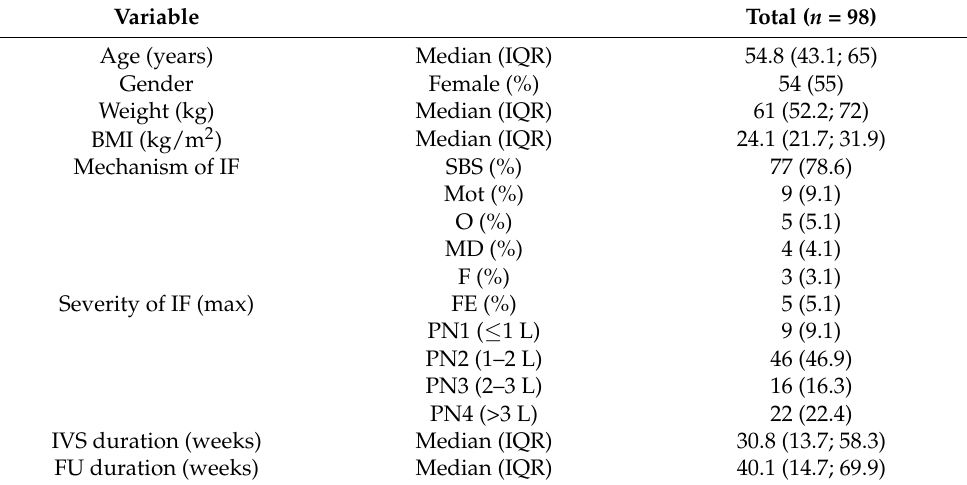
Table 1. Demographics and clinical characteristics of IF patients at the start of IVS.